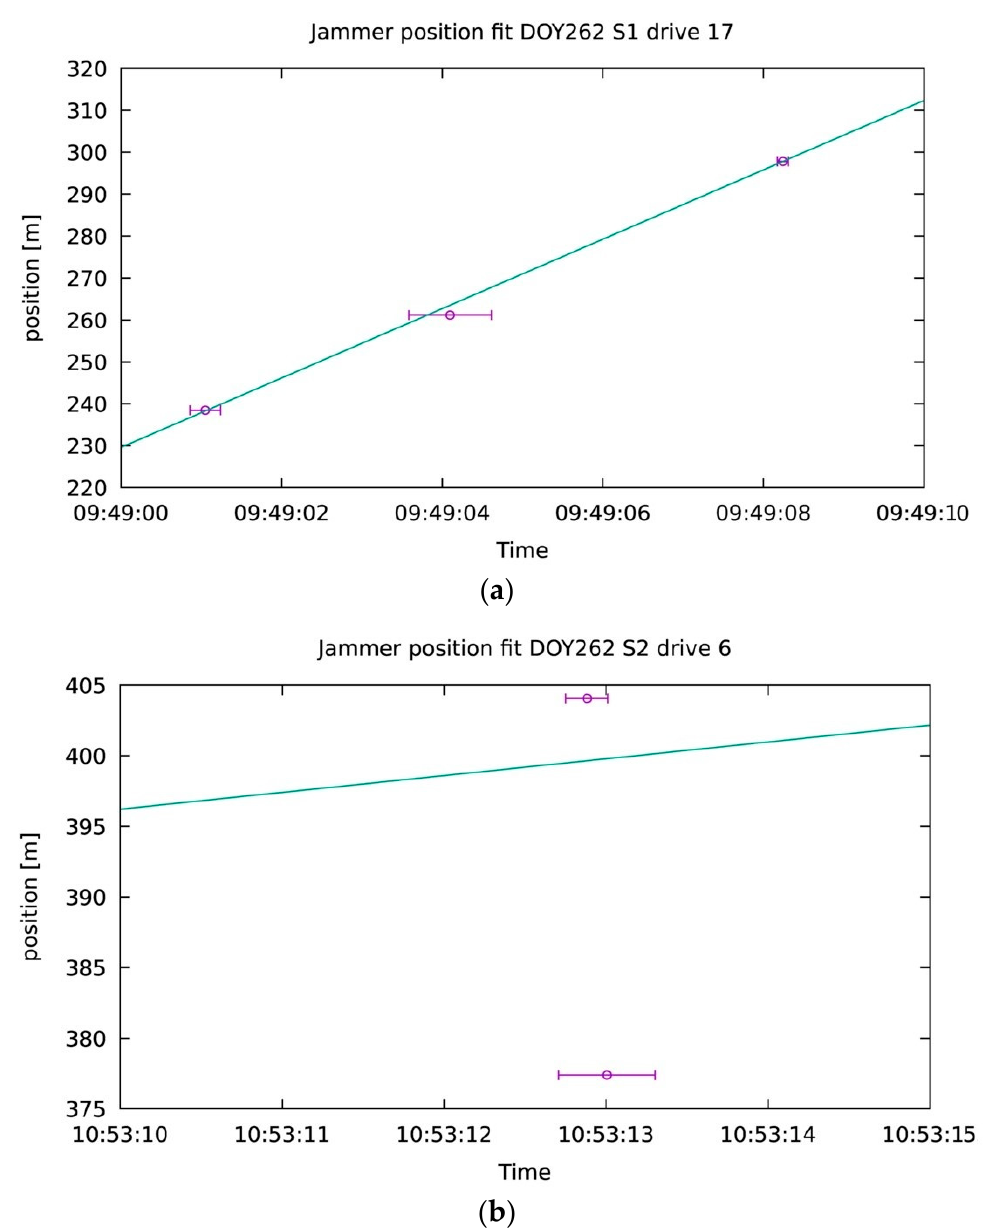
Figure 10. Examples of fitting the path of the jammer to the calculated points: ( a ) good compliance; and ( b ) bad